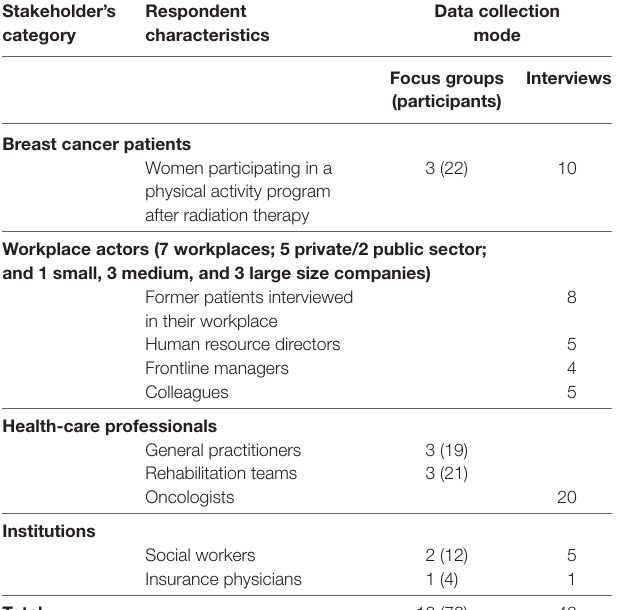
TaBle 1 | Respondent characteristics and data collection mode. stakeholder’s